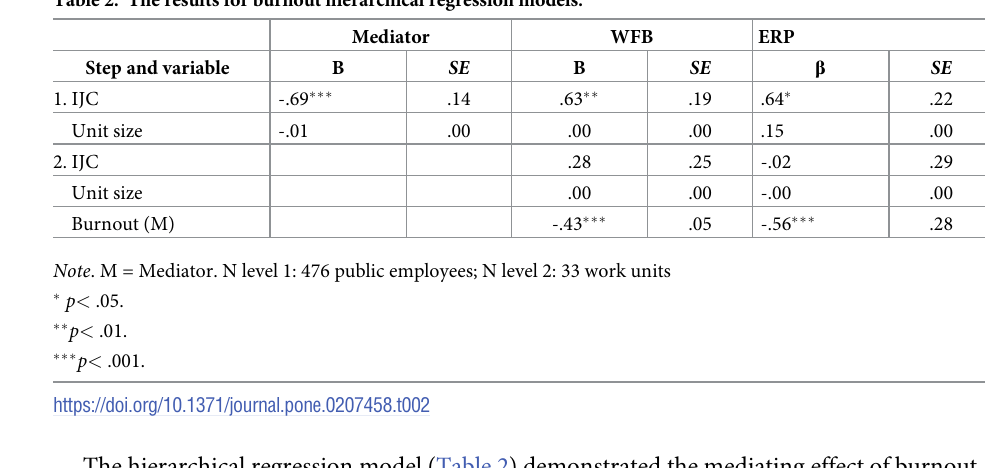
The hierarchical regression model (Table 2) demonstrated the mediating effect of burnout on the relationship between IJC, WFB, and ERP. First, the results show the positive and signifi- cant influence of IJC at the work team level on WFB ( β = .63, p < .01), and ERP ( β = .64, p < .05). The results also indicate the significant and negative influence of IJC at the work team level on burnout, ( β = -69, p < .001).None of the three variables influenced the size variable of the work unit, which was used as a control variable (WFB: β = .00, p > .05, ERP: β = .15, p > .05, burnout: β = -.01, p > .05). The second step showed that the significant effects of IJC at the work team level on WFB and ERP disappear (WFB: β = .28, p > .05, ERP: β = -.02, p > .05).The non-significant effects of the size of the work team were maintained. These results confirm the total mediation of burnout on IJC at the work team level, WFB and ERP. The second regression model provided the results of the mediating effect of engagement on the relationships between IJC on WFB and ERP. The results provided in Table 3, indicate the positive and significant influence of IJC on WFB ( β = .63, p < .01) and ERP ( β = .64, p < .05). Furthermore, the results show the significant and positive influence of IJC on engagement( β = .27, p < .001). None of the three variables influenced the size of the work team (WFB: β = .00, p. ns; ERP: β = .15, p > .05, burnout: β = .01, p > .05). The second step demonstrated that the effects of IJC at the work team level on WFB and ERP were no longer significant (WFB: β = .14, p > .05, ERP: β = -0.4, p > .05). In this step, the non-significant effects of the size of the work team were repeated. These results confirm the total mediation of engagement in the influence of IJC at the work team level on WFB and ERP.